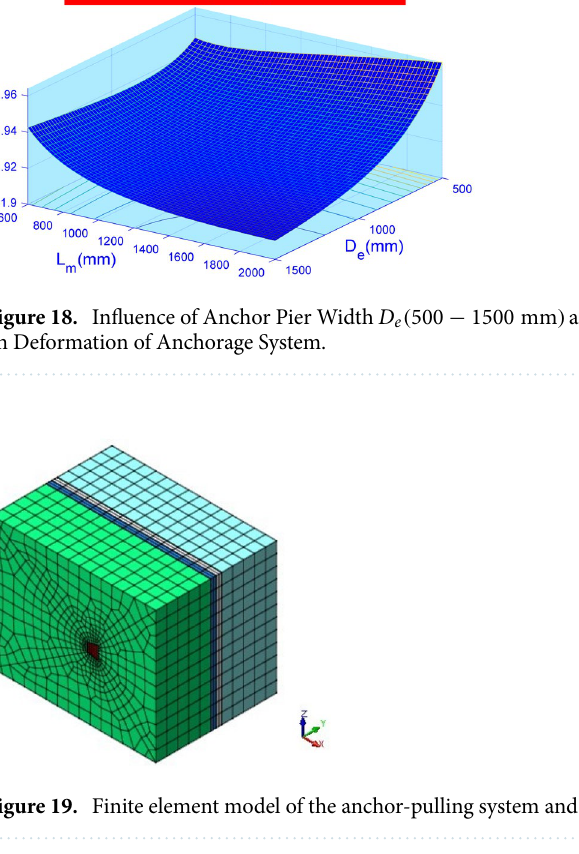
Figure 19. Finite element model of the anchor-pulling system and surrounding